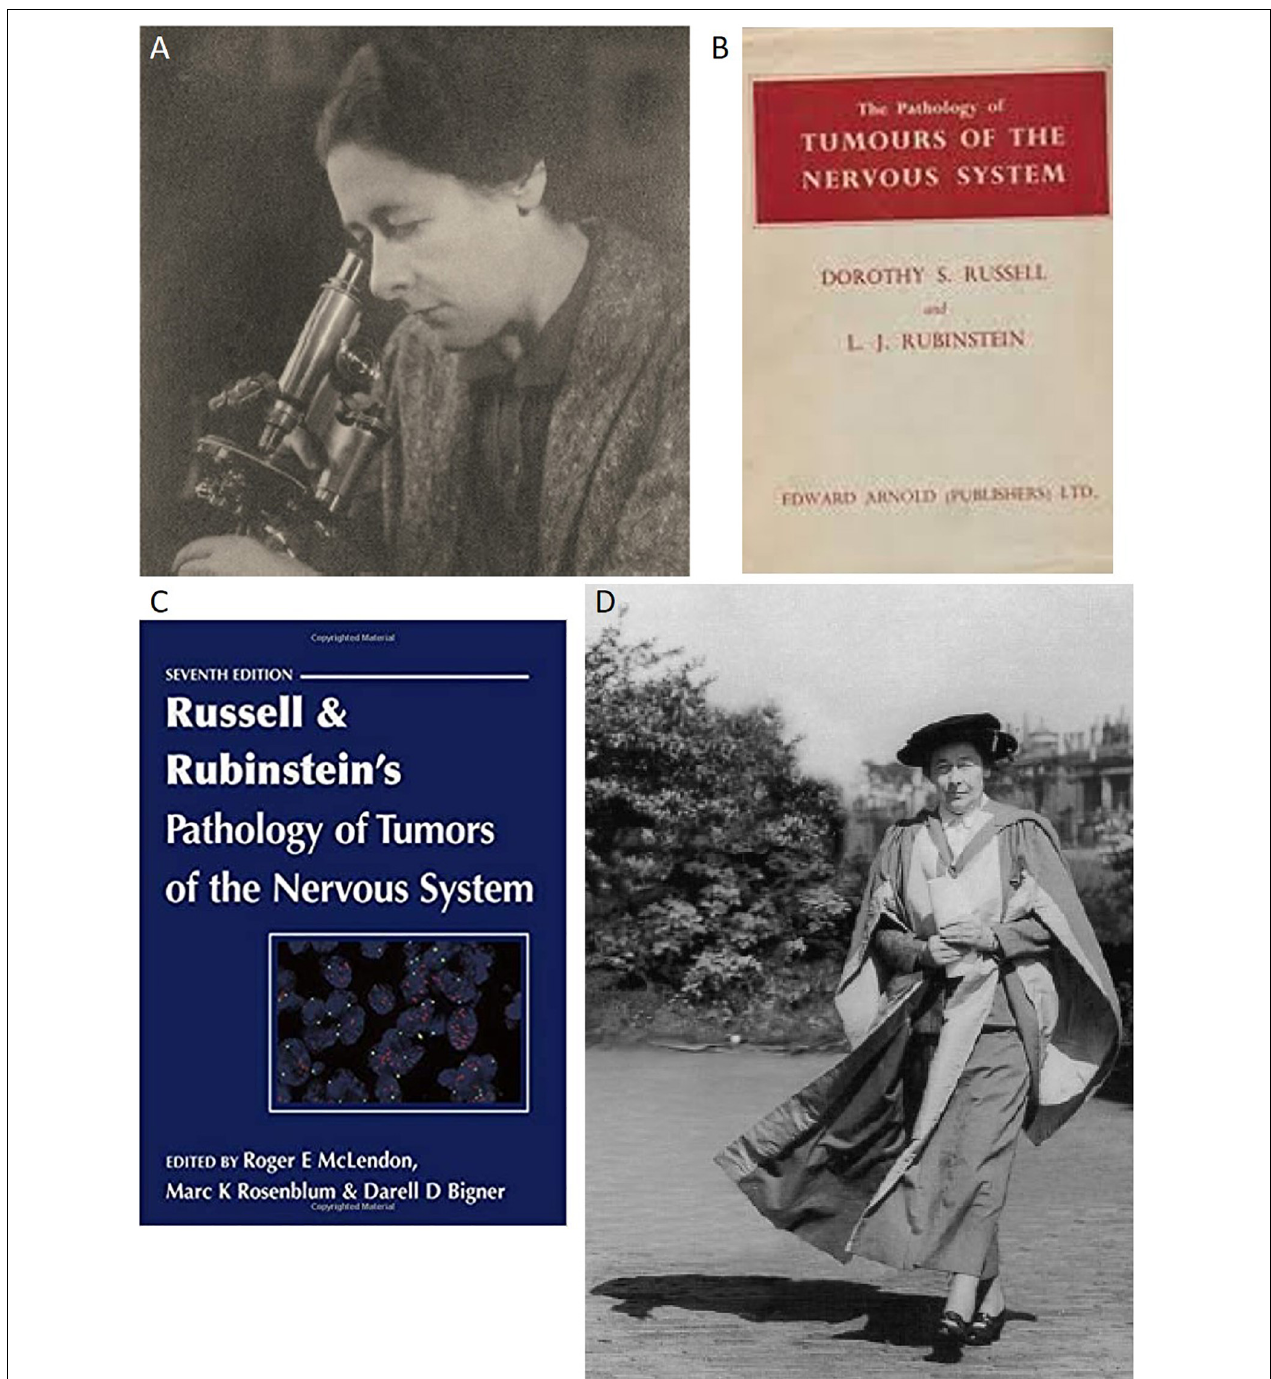
FIGURE 5 | The women disciples of Río-Hortega after the death of Don Pío (I). (A) Dr. Dorothy Russell at the microscope, during her scientific maturity. (B) First edition of the textbook on the tumors of the brain by Russell and Rubinstein (1959). (C) Fifth edition of the Russell and Rubenstein textbook (Russell and Rubinstein, 1989). (D) Dorothy Russell receives her doctor honoris causa from the University of Glasgow